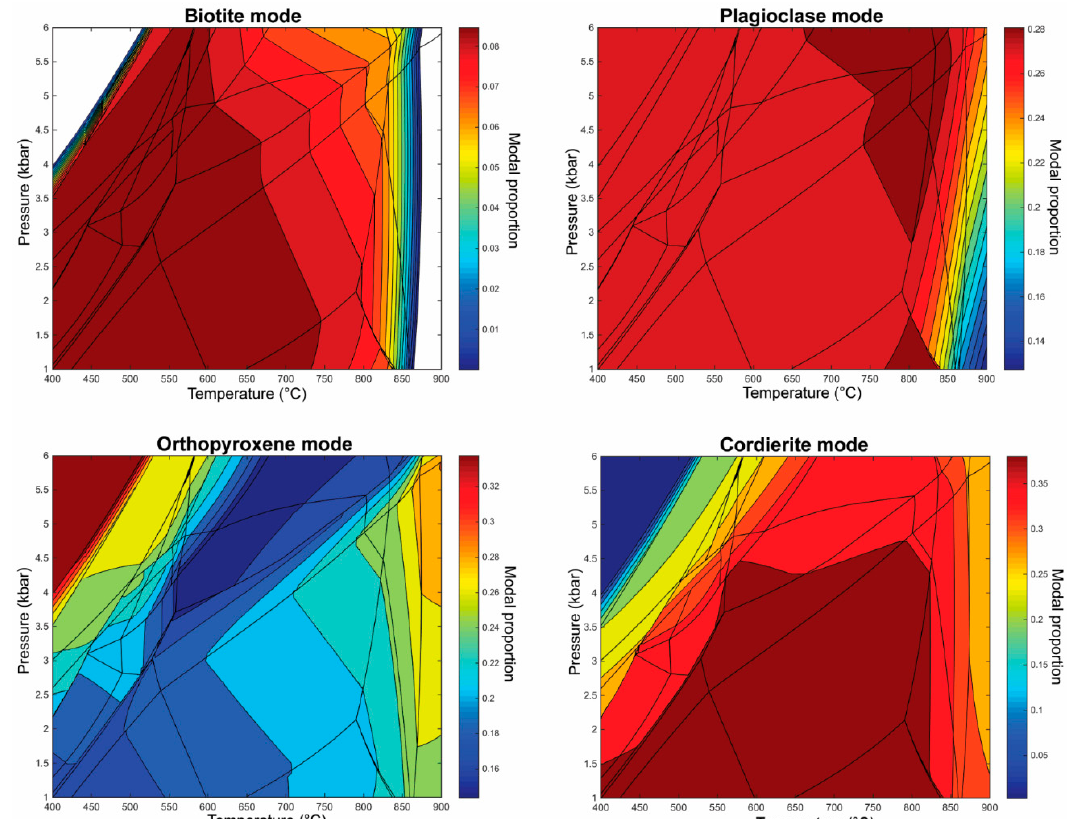
Figure A3. Mineral modal abundance contour diagrams produced using TCInvestigator [45] for the major phases that occur in the peak assemblage of sample 14-RDC-04. These diagrams were used to construct Figure 4b in the main text.